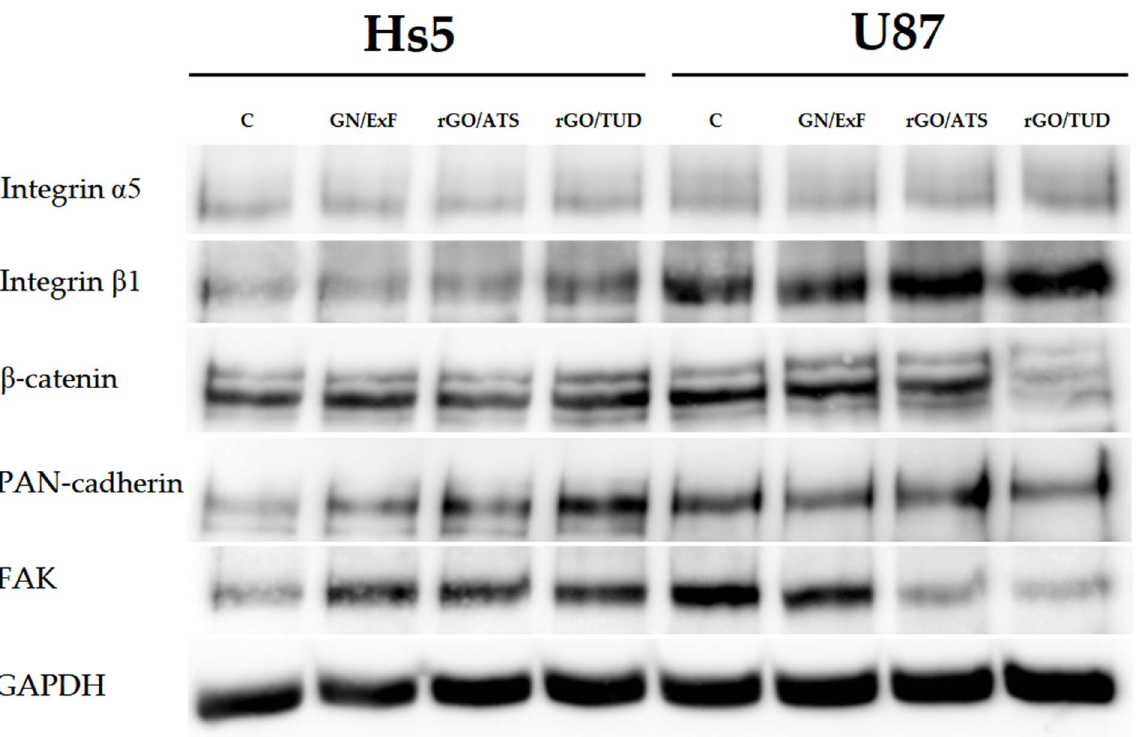
Figure 6. Western blot analysis of integrin α5, integrin β1, β-catenin, PAN-cadherin, and FAK after GN and rGO treatment at 25 μg/mL concentration for 24 h in U87 and Hs5 cells. GAPDH was used as a loading control. Abbreviations: rGO, reduced graphene oxide; GN, graphene; C, control group (untreated group); ExF, exfoliation; term, thermal; ATS, ammonium thiosulfate; TUD, thiourea dioxide; GAPDH, glyceraldehyde 3-phosphate dehydrogenase.